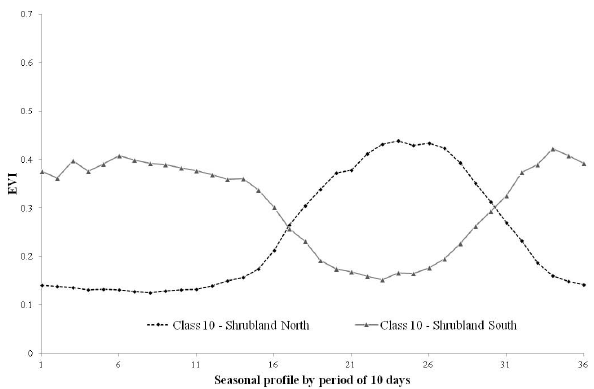
Fig. 5. EVI Seasonal profile by period of 10 days (January to De- cember between the vertical lines) for classes (1, 4, 5 and 7) situated in the central forest